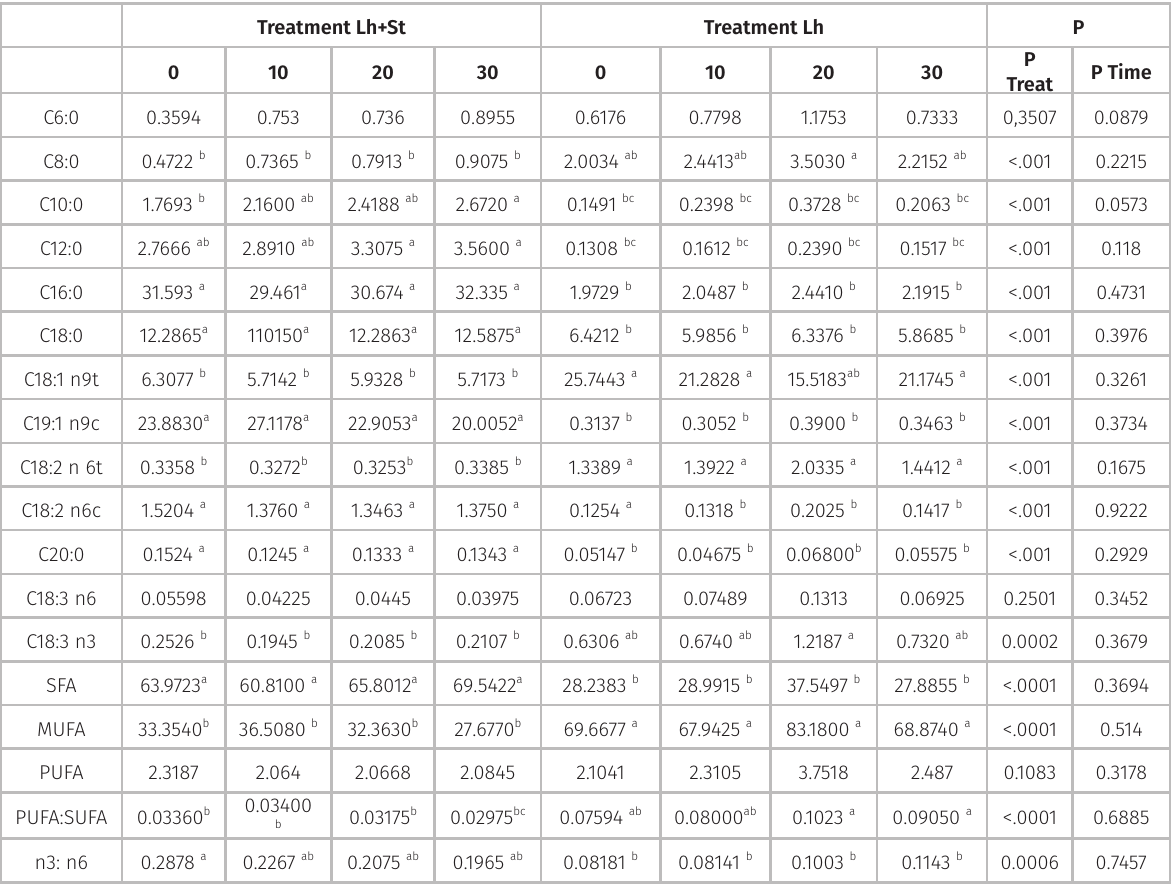
Table VIII. Profile of fatty acids in samples of ripened cheese (mg/g fat). Treatment Lh+St Treatment